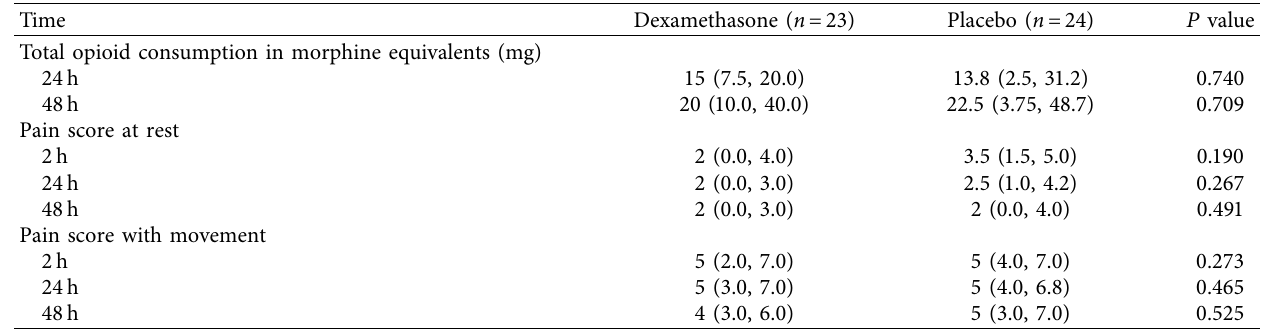
Table 2: Postoperative analgesic